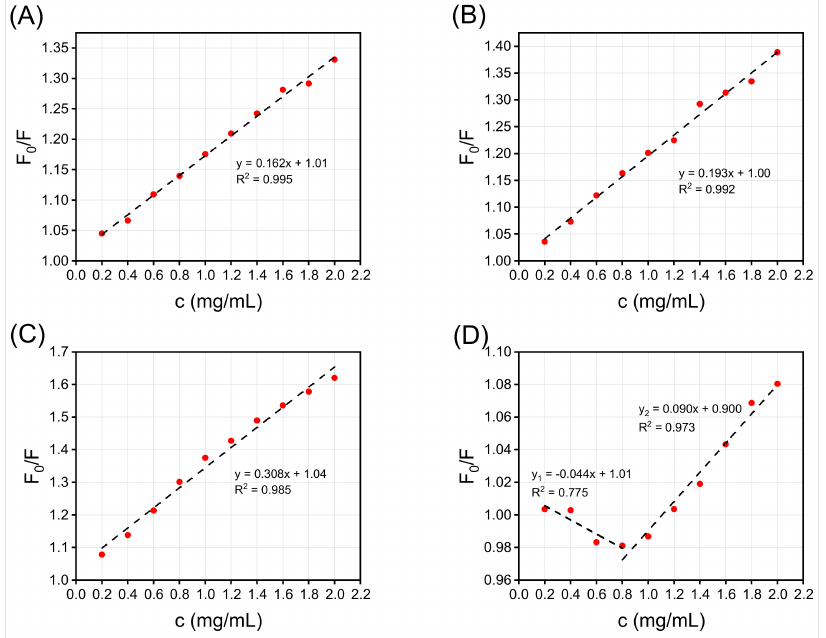
Figure 7. The effects of MCC ( A ), CMCC-1 ( B ), CMCC-2 ( C ), and CMCC-3 ( D ) on the fluorescence of 1 mg/mL SPI; the relationship between F 0 /F and c (MCC/CMCC) was analyzed on the basis of Equation (3), with the slope determined as the quenching constant K SV